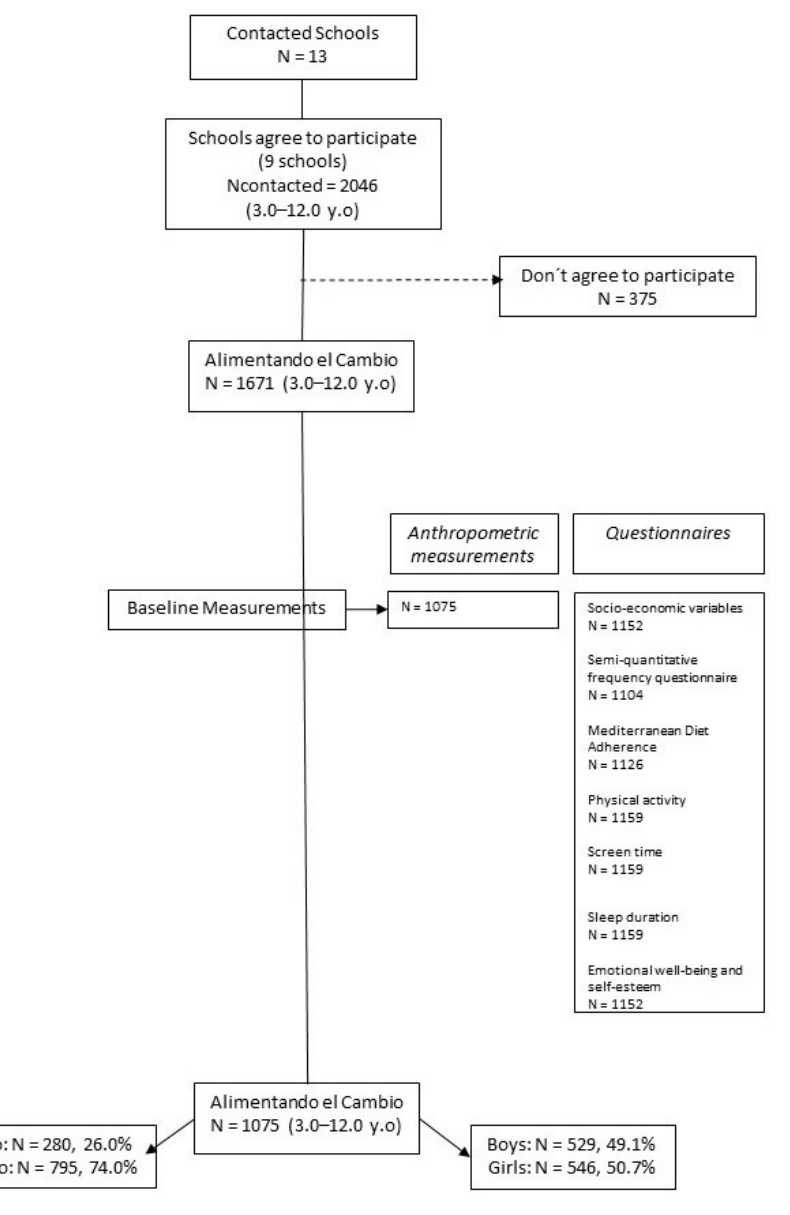
Figure 1. Flow chart of the participants involved in this study from ‘Alimentando el cambio’.